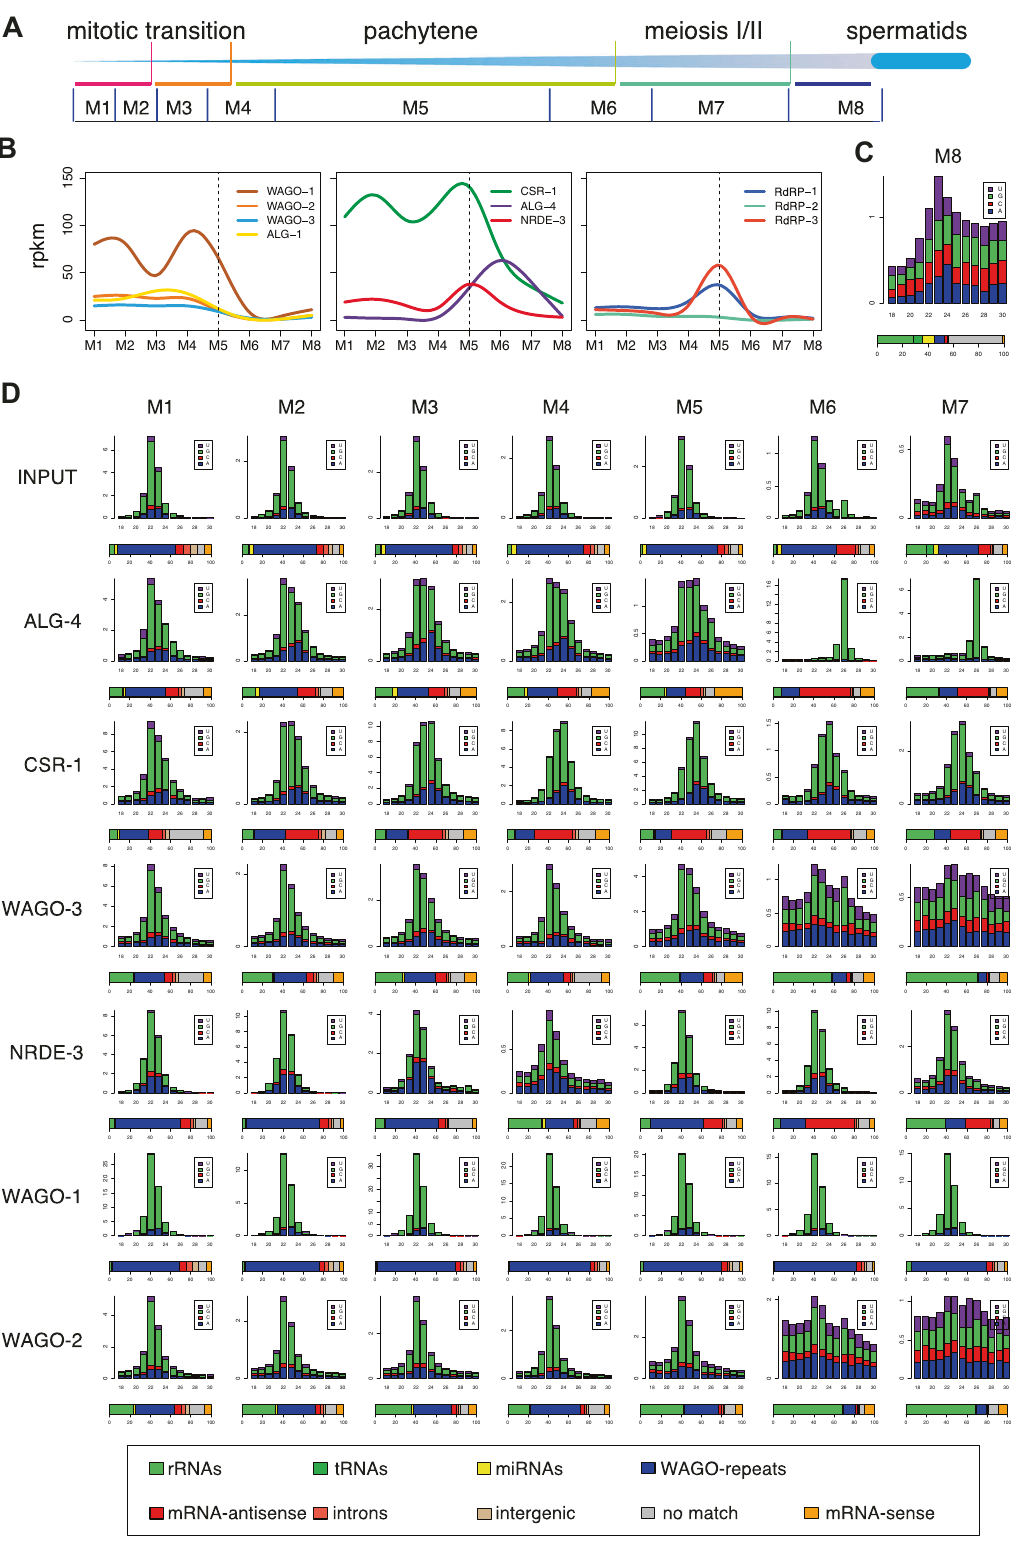
Fig. 4 Small RNAs associated with Ascaris Argonautes during spermatogenesis. A Illustration of Ascaris stages of spermatogenesis from Fig. 3. B RNA expression pro fi les of Ascaris Argonautes and RdRPs throughout spermatogenesis. The Argonautes are plotted in two groups based on their expression pattern or their targets. The RNA-seq expression data are provided as a Source Data fi le. C Small RNAs from mature spermatids (M8). The random size distribution pattern illustrates the low levels of bona fi de small RNAs. D Small RNAs during spermatogenesis (M1 – M7). In C and D , the size distribution, frequency, and classi fi cation of small RNAs are as described as in Fig.